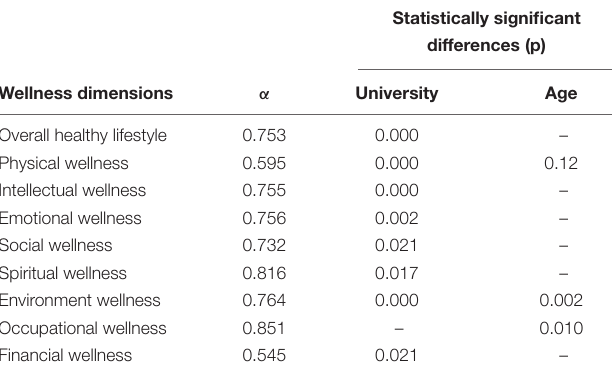
TABLE 5 | Differences with regards to country of sport students.